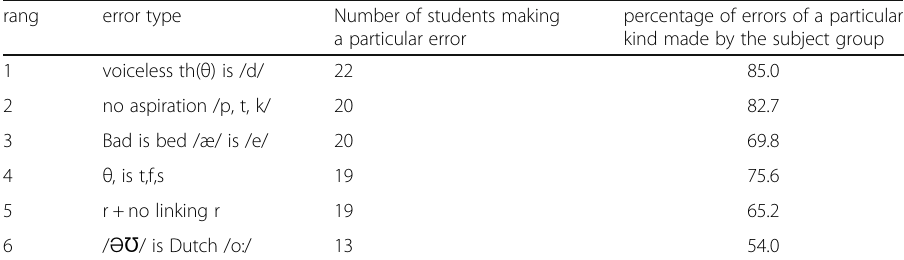
Table 1 Error types that are made by more than half of the students in more than 50% of the cases in which such a mistake could be made in the tests set to the students rang error type Number of students making percentage of errors of a particular a particular error kind made by the subject